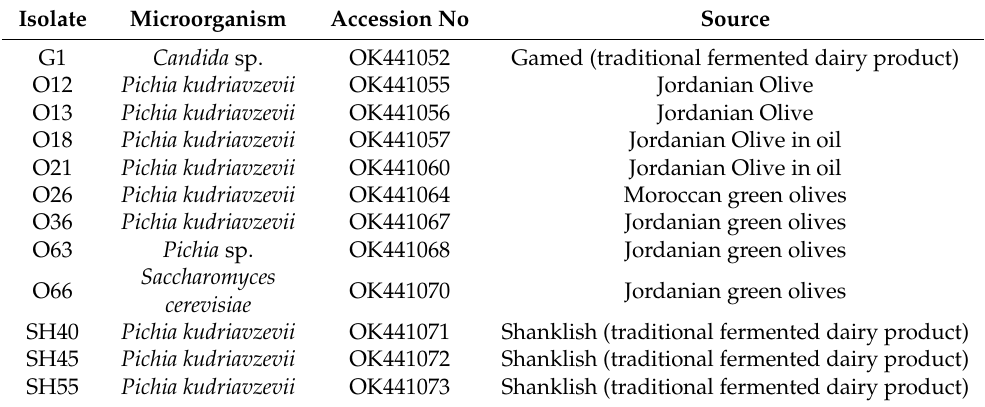
Table 7. Identification of yeast isolates using ITS/5.8S ribosomal DNA and their accession numbers obtained from